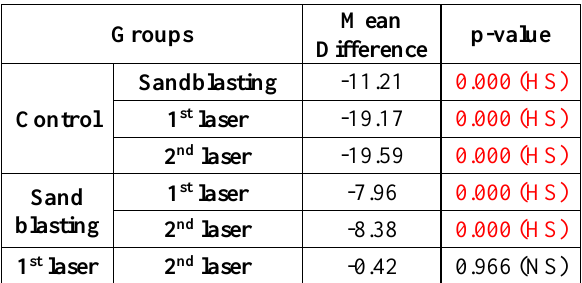
Adhesive remnant index “ARI”